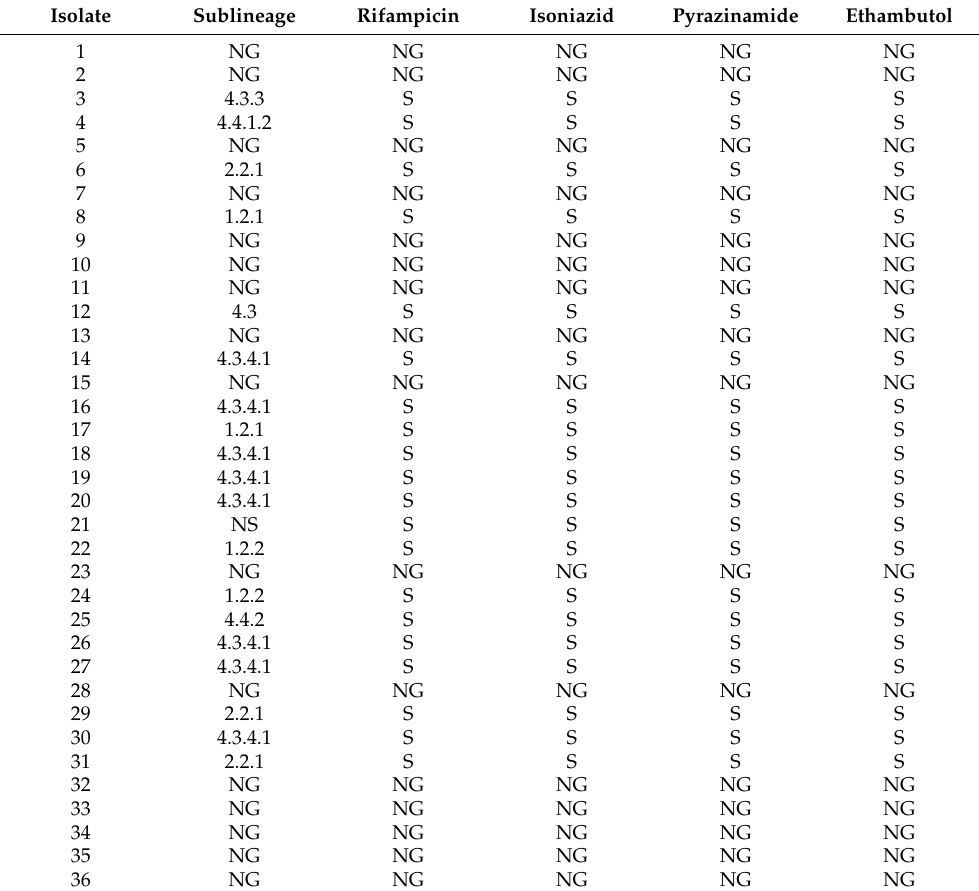
Table 1. Summary of culture and DST of 36 sputum isolates.